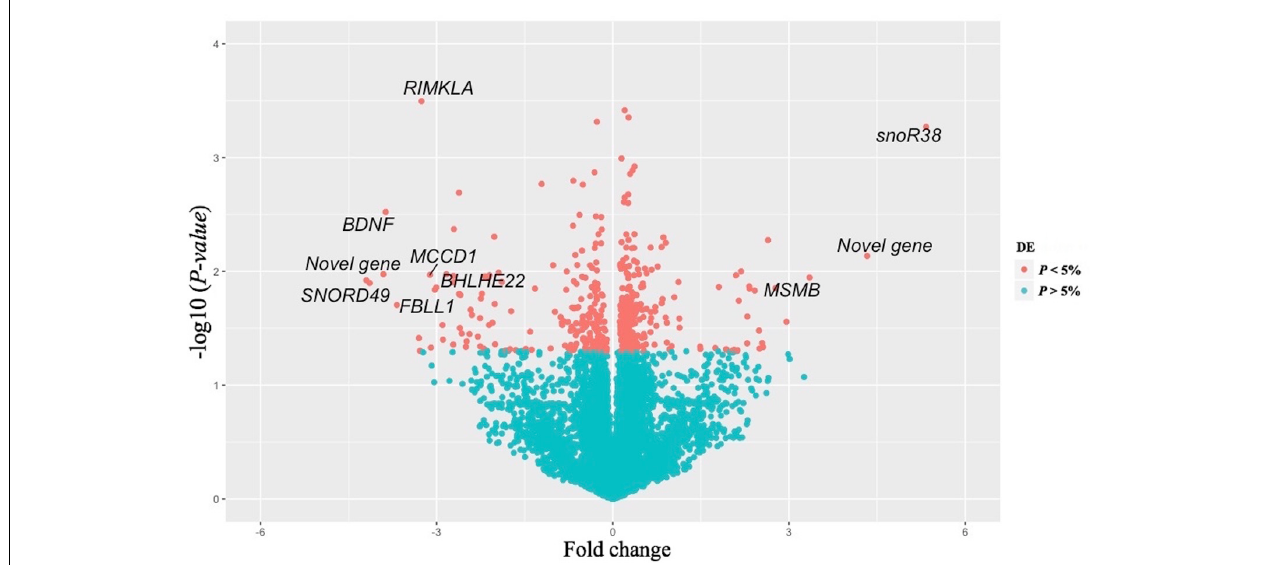
FIGURE 1 | Volcano plot of differentially expressed genes ( N = 452) in liver between pre- vs post-pubertal heifers. The x -axis represents the FC while the y -axis represents statistical significance for each gene. Red dots indicate genes that differ significantly ( P < 0.05) between the two groups. Genes plotted in the left portion of the graph were expressed at a lower level in post-pubertal liver, and gene in the right-hand portion had higher expression levels post-puberty. Gene symbols are provided for genes with a |FC| ≥ 3 and P ≤